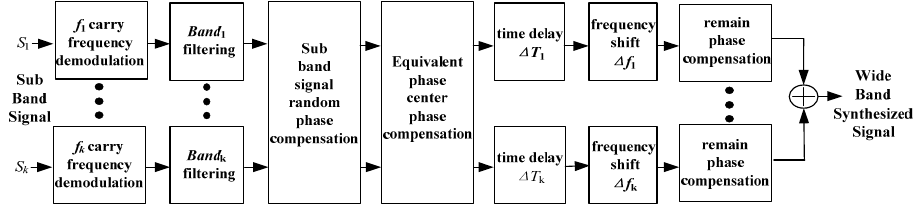
Figure 7. Range MIMO SAR signal preprocessing flowchart.